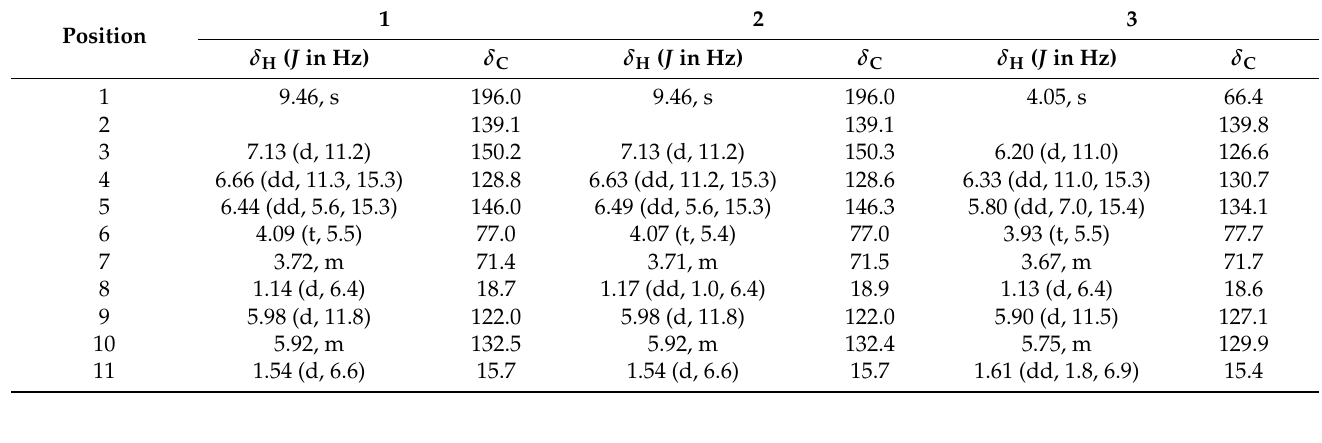
Table 1. 1 H and 13 C NMR data for 1 – 3 at 600 MHz and 150 MHz in CD 3 OD ( δ in ppm, J in Hz), respectively.